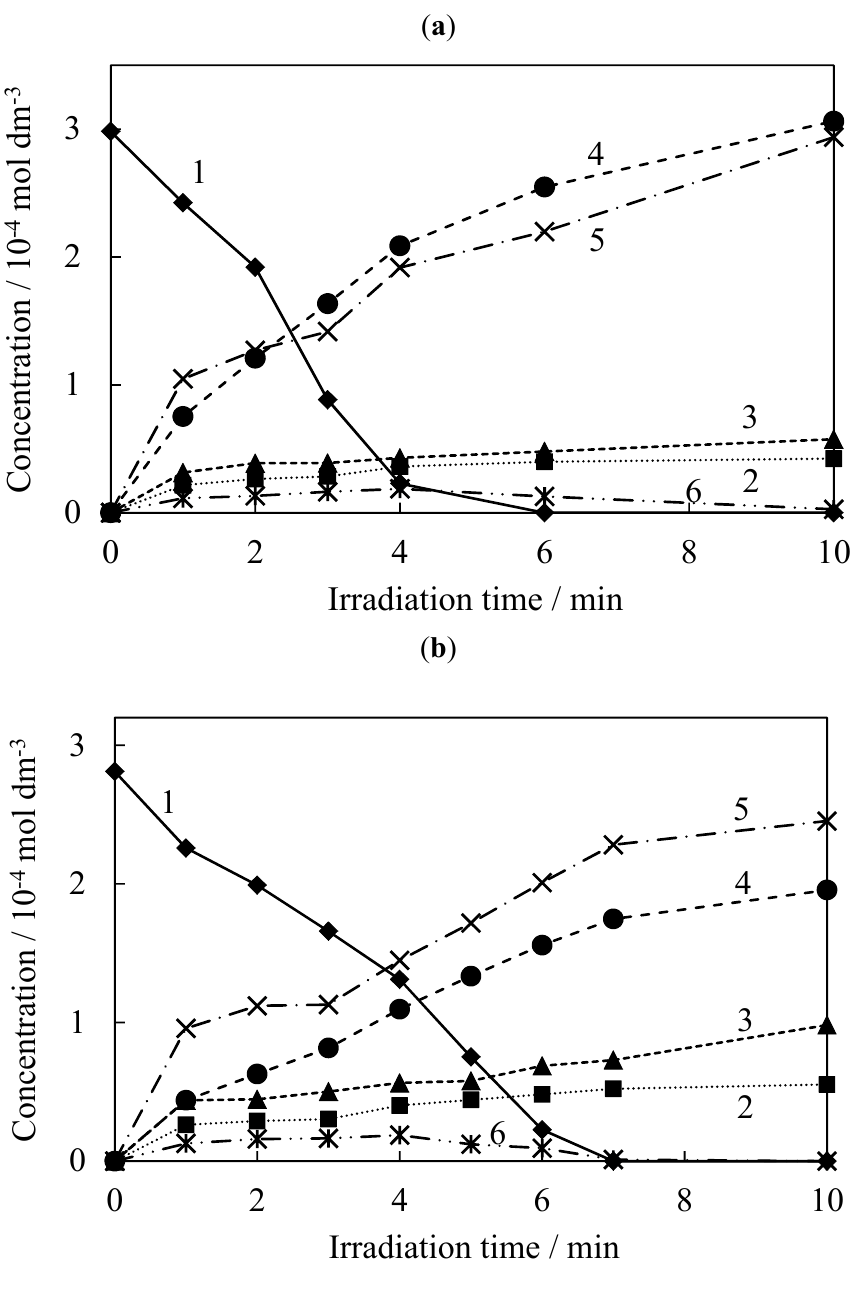
Figure 7. Time course of concentrations of (1) TCE and each product; (2) CO; (3) CO ; (5) HCl and (6) DCAC, during photocatalytic degradation of TCE using ( a ) (4) COCl 2 Sample T and ( b , c ) Sample S400 during ( a , b ) UV or ( c ) visible